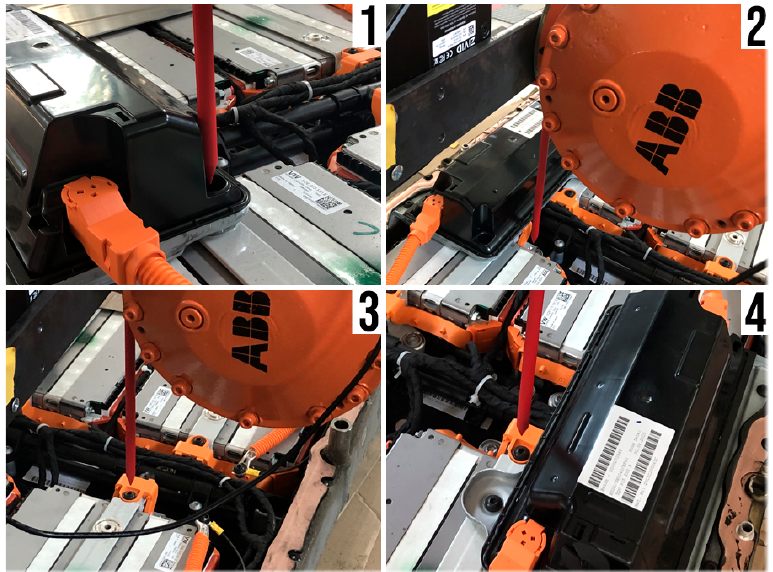
Figure 13. Accuracy tests showing the red pointer 3 cm above one detected screw. Four different views of the same position.